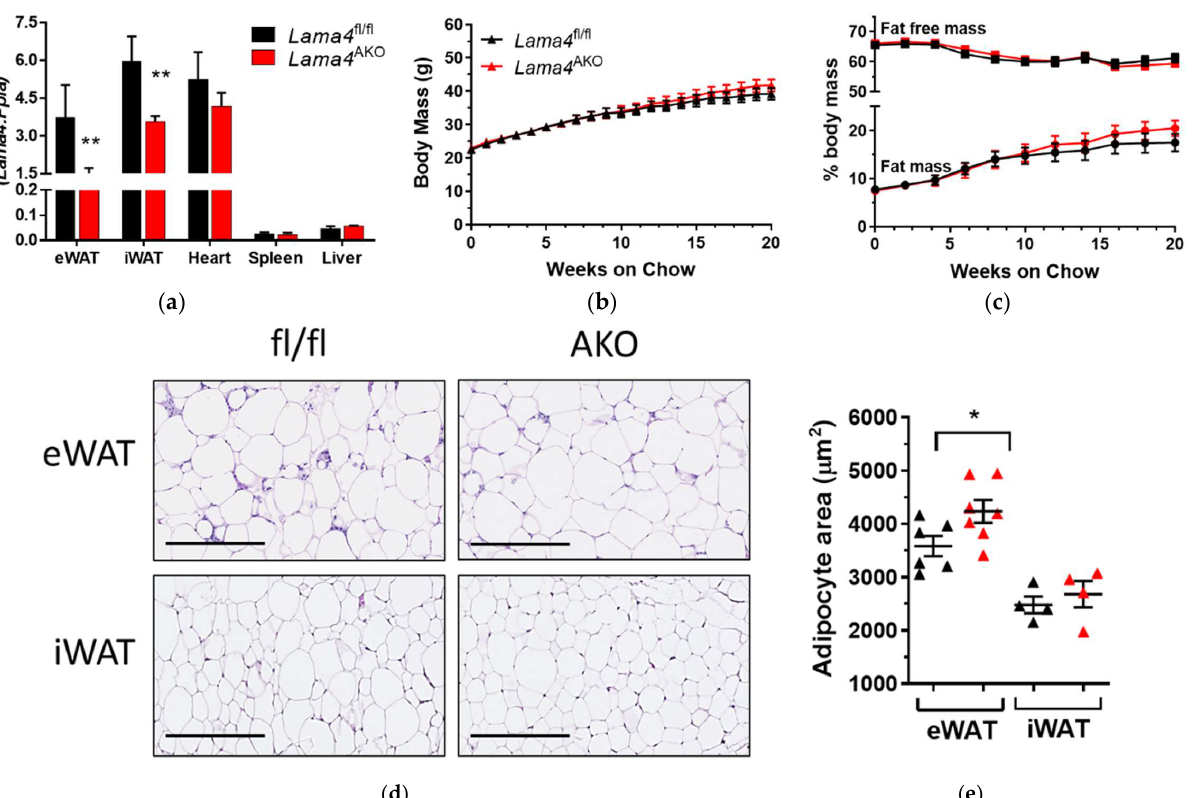
( d ) Figure 2. Laminin α4 is highly expressed in human and mouse adipocytes. ( a ) Uniform manifold approximation and projection (UMAP) embedding coordinates from single nucleus RNA-sequenc-